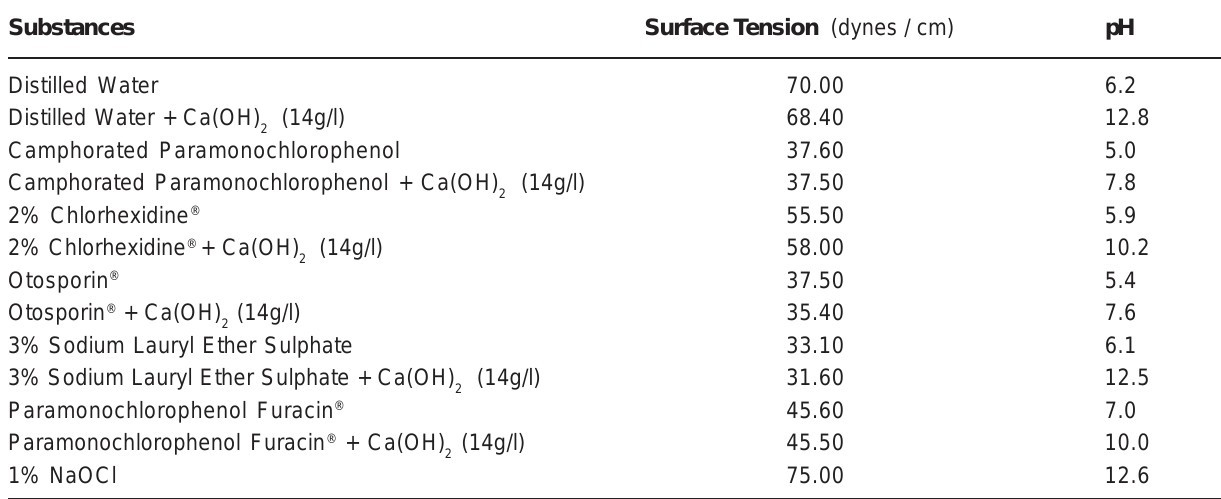
TABLE 1- Surface tension values of calcium hydroxide associated with different substances